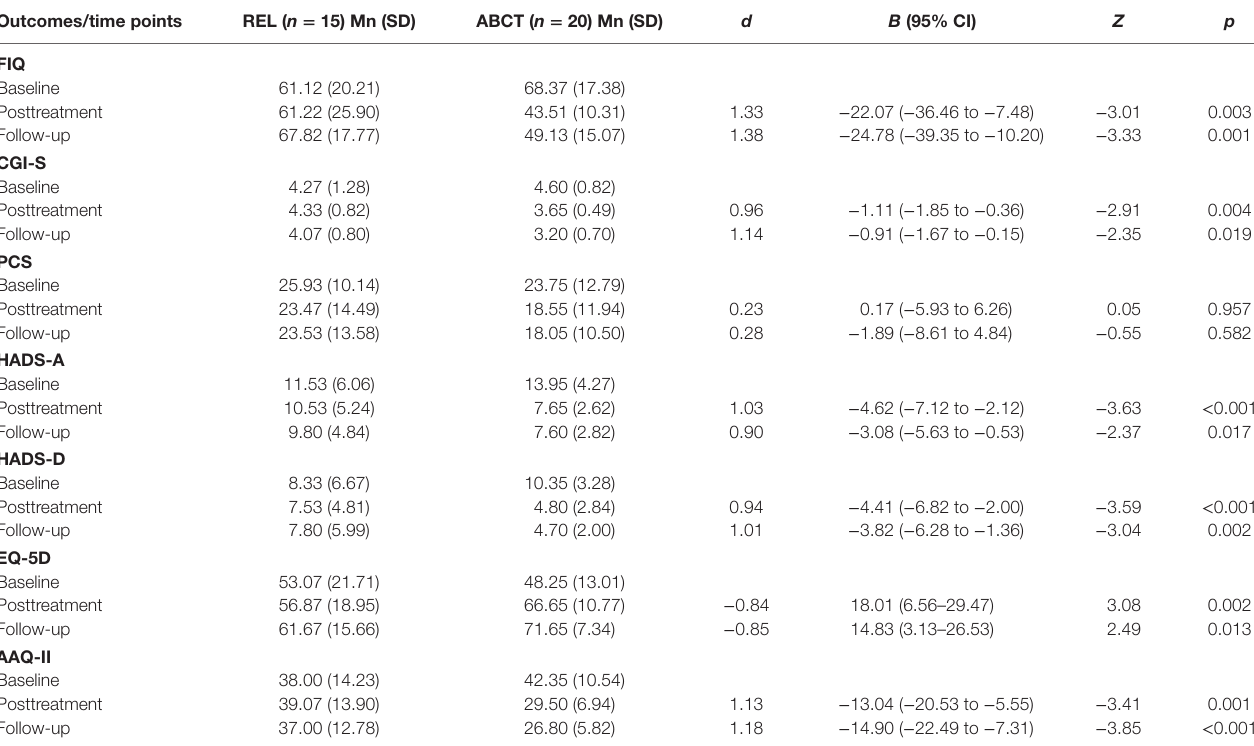
TaBle 3 | Descriptive statistics and between-group analyses with observed data. Outcomes/time